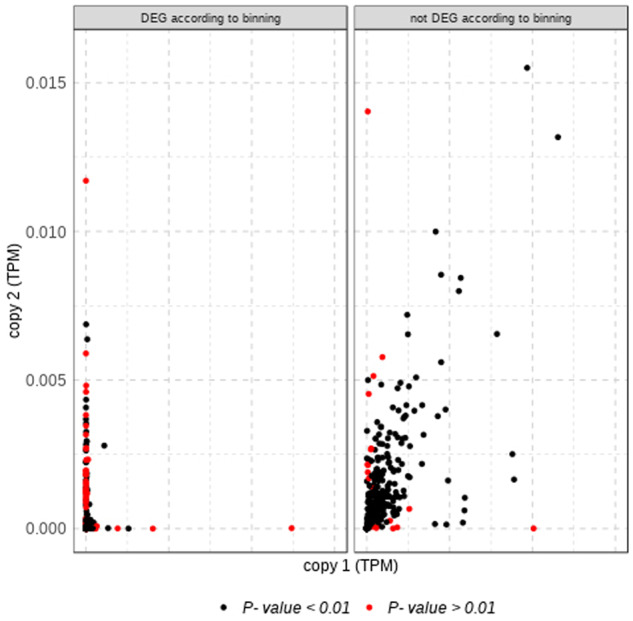
Scatterplot showing median gene expression between pairs of duplicates for the “strict duplications” subset. Colors correspond to the P values of a Pearson correlation (see Materials and Methods for details). The significance of the test should be interpreted with caution for those genes that are lowly expressed (i.e., those located in the lower left corner). For visualization purposes, we discarded five gene pairs that were outliers in the subset “not DEG according to binning.”